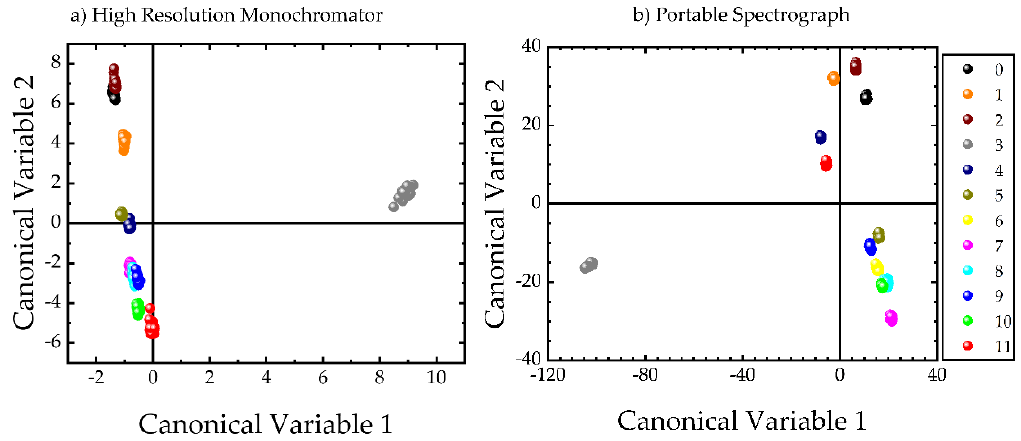
Figure 7. Canonical Variable plots obtained from the Linear Discriminant Analysis (LDA) model for the spectra obtained from ( a ) the high-resolution monochromator and ( b ) the portable spectrograph.